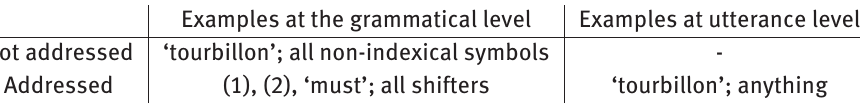
Table 2: Adressivity at the level of grammar and at that of the utterance Examples at the grammatical